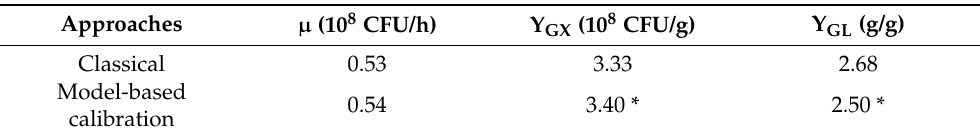
Table 2. Optimized process parameters calculated with the classical and modal-based calibration